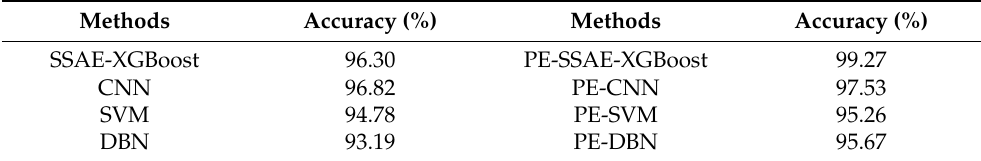
Table 4. Comparison of diagnosis accuracy.